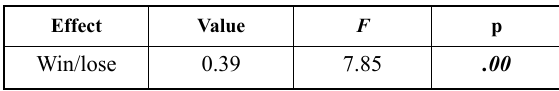
Table 3. Multivariate analysis of variance between successful